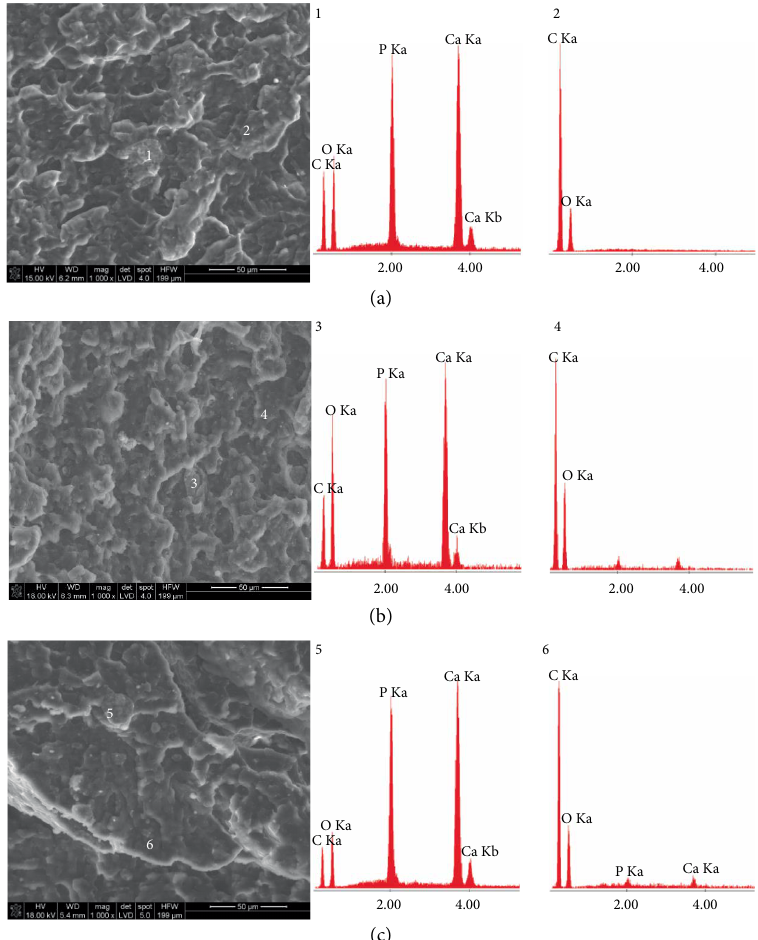
Figure 11: SEM/EDX analysis of POM/1.0% HA- g -PEG 600 (a), POM/1.0% HA- g -PEG 2000 (b), and POM/1.0% HA- g -PEG 6000